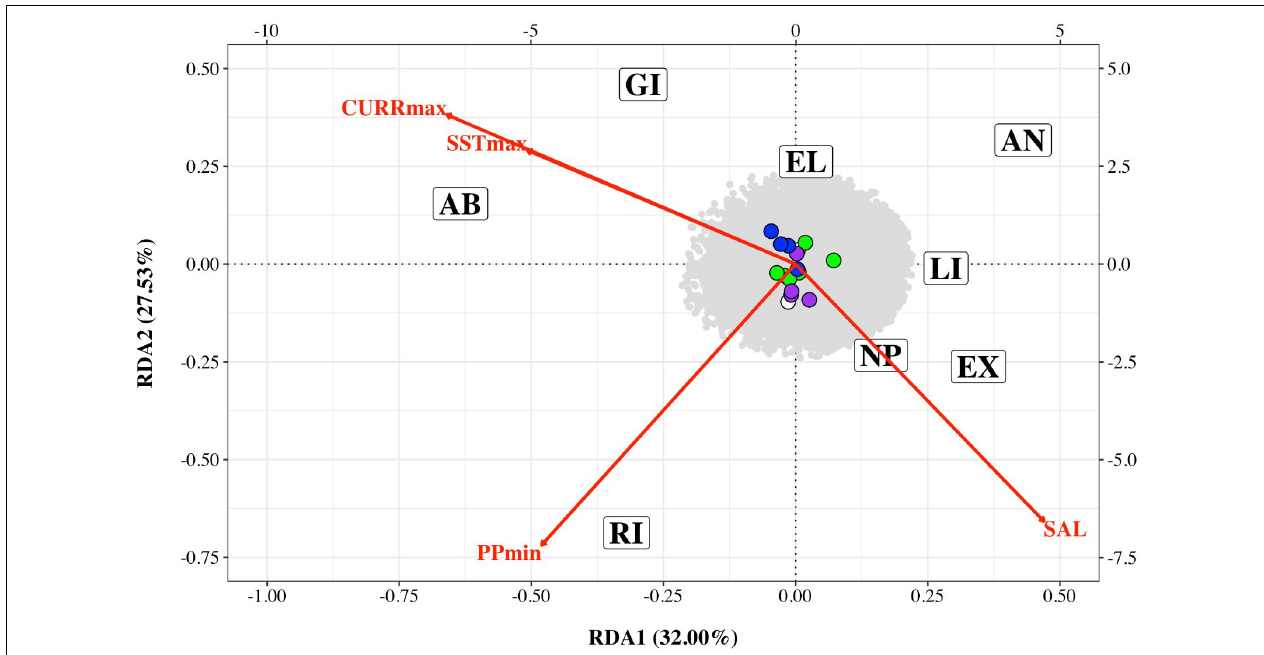
FIGURE 4 | Redundancy analysis triplot of association between Nassau grouper single nucleotide polymorphism (SNP) frequency and four environmental variables: maximum current velocity (CURRmax), minimum primary productivity (PPmin), maximum sea surface temperature (SSTmax) and salinity (SAL) for eight sampling locations (AB, Abaco; AN, Andros; EL, Eleuthera; EX, Exuma; GI, Great Inagua; LI, Long Island; NP, New Providence; RI, Ragged Island). SNPs associated with each environmental variable are color coded (CURRmax – purple, PPmin – green, SSTmax – white and SAL – blue). The bottom and left axes relate to site and environmental variable scores while the top and right axes relate to SNPs